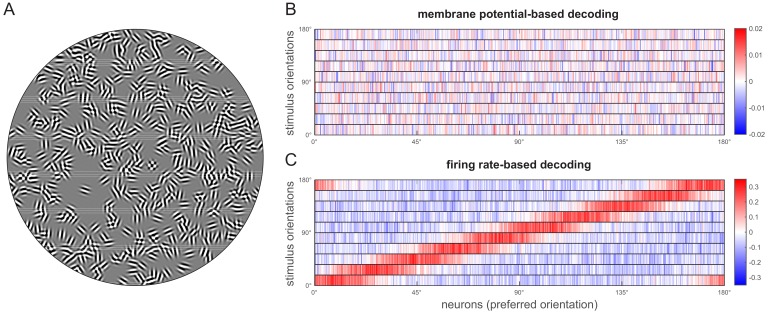
Properties of the model neuron population.(A) Gabor filters characterising the model neurons. A fixed set of Gabor filters was used throughout the simulations (but see Figure 4—figure supplement 1) that characterise the receptive field properties of the model neuron population. Receptive field locations were randomly sampled on a 90 degree circle (approximating the visual field), with random orientations and phase but fixed spatial frequency and receptive field size (see Materials and methods and Table 1). (B) Representation of the linear decoder parameters trained for membrane potential decoding (top panel) and firing rate decoding (lower panel). Colour code shows the strength of the connection between model neurons and the orientations the decoder distinguishes. There is no clear pattern in the connection strengths of the membrane potential decoder. In the case of the firing rate decoder, however, stronger weights are characteristic of neurons with preferred orientations matching the orientations represented by the decoder. Note the different colour scales in B and C.